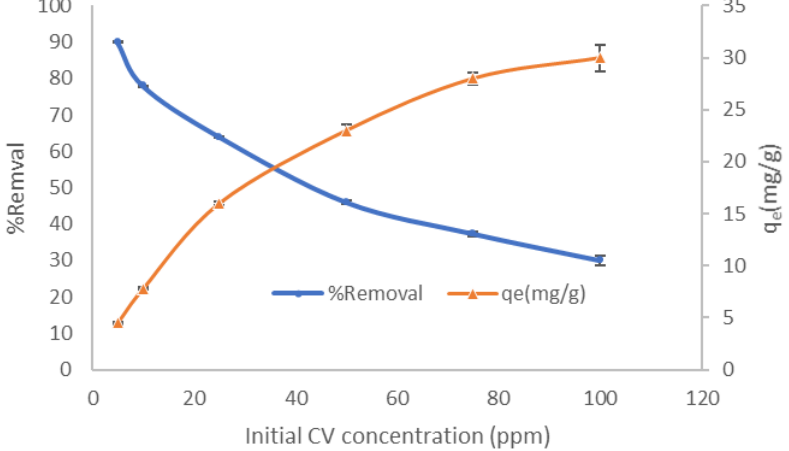
Figure 9. Effect of initial CV concentration on % removal and adsorption capacity using LCF.